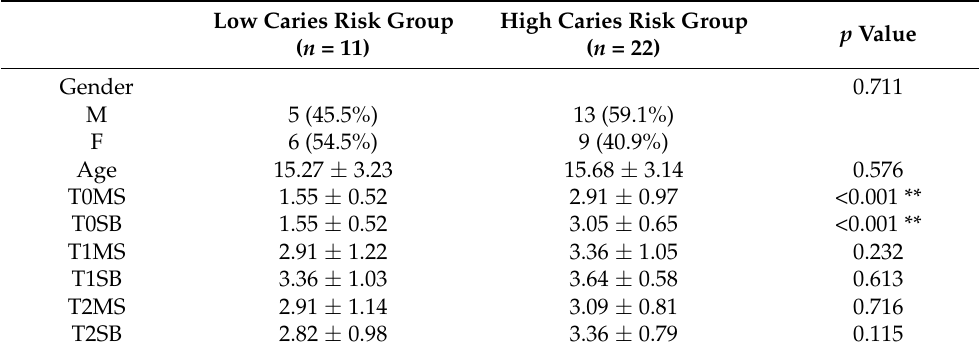
Table 2. Comparison of high and low caries risk groups in gender, age, and bacteria counts at different time